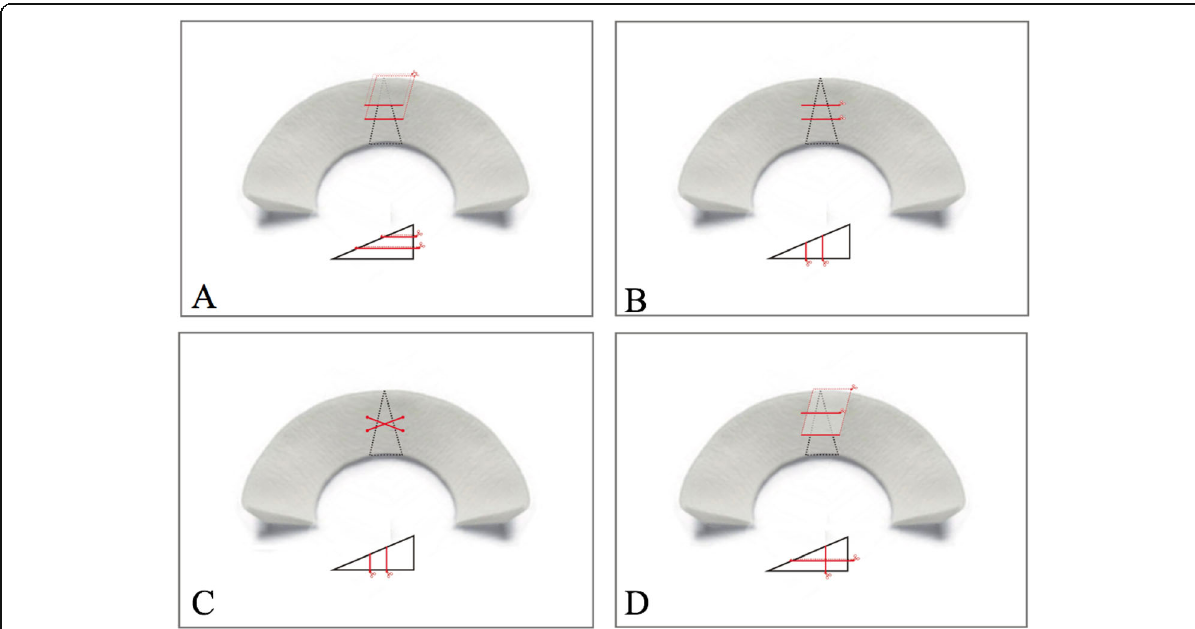
Fig. 2 Illustration of meniscus repair techniques: a double horizontal technique, b double vertical technique, c double vertical cross technique, d hybrid technique